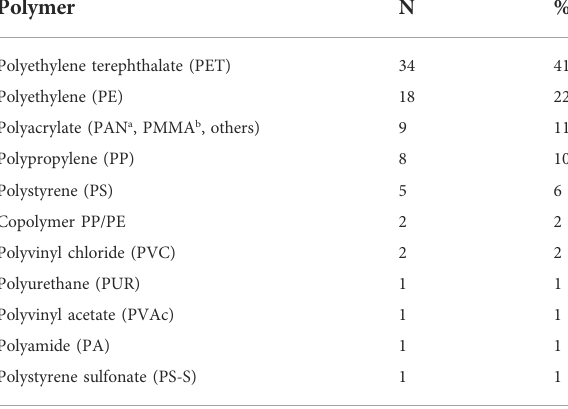
TABLE 3 MPs number and relative abundance (%) of each